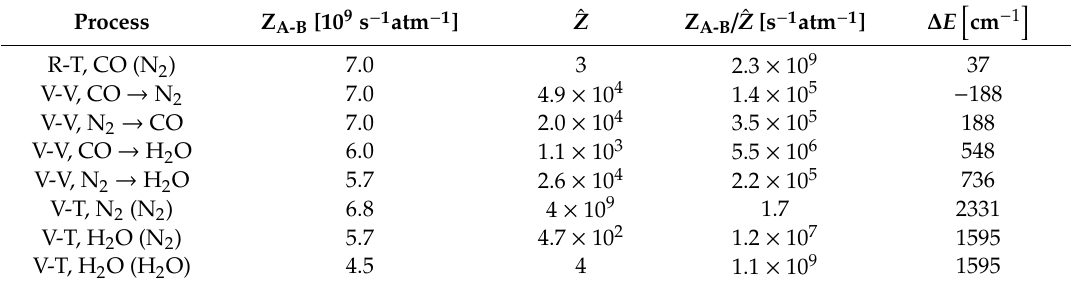
Figure 3. Energy levels of CO, N 2 , and H 2 O involved in the collisional relaxation of CO. Straight arrows indicate energy transfer in collisions and the kind of transfer is given in parenthesis: {R-T, A} denotes rotational relaxation, {V-T, A (B)} denotes the vibrational-translational relaxation of A in collisions with B, and {V-V, A → B} denotes V–V transfer from A to B. The rates γ for each energy transfer, normalized to the partial pressure of the collision partner, is given for T = 298 K, compare Table 1. Table 1. Summary of processes involved in the relaxation of CO. Collision frequencies Z A-B were normalized to the partial pressure of the collision partner B. “R-T, A (B)” and “V-T, A (B)” denote R–T and V–T relaxation of A in collisions with B. “V-V, A → B” denotes the V–V transfer from A to B. ∆ E denotes the energy released in the process (negative for energy uptake). Collision numbers ˆ Z were obtained from [2,19–22]). All values are given for T = 298 K.